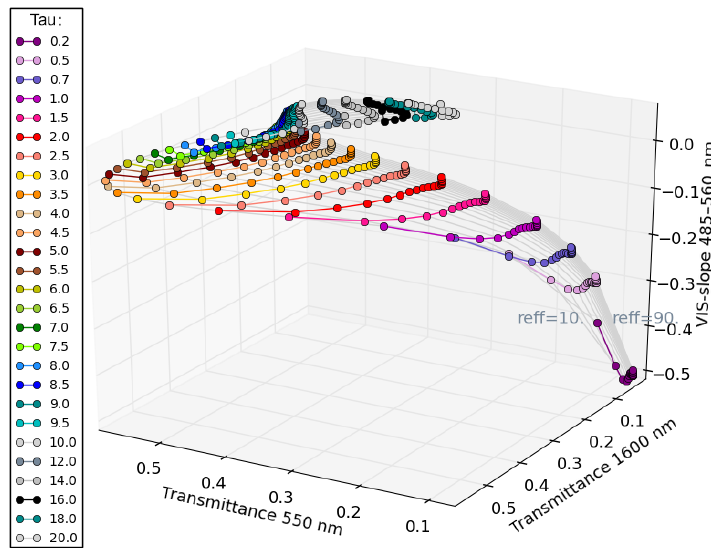
Figure 5. Three-dimensional lookup table using transmittances at 550, 1600nm and the spectral slope S VIS in the range 485–560nm (simu- lation for θ 0 = 36 ◦ , θ v = 0 ◦ , φ rel = 180 ◦ and habit